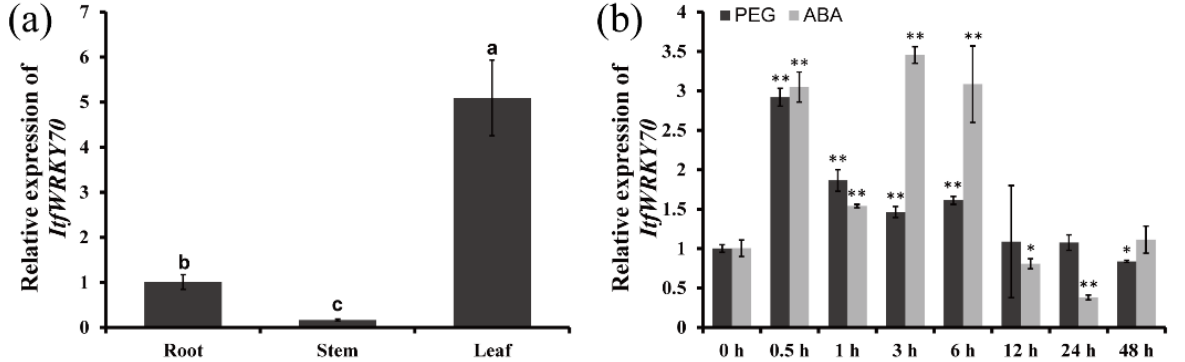
Figure 2. Expression analysis of ItfWRKY70 . ( a ) Expression analysis of ItfWRKY70 in root, stem and leaf tissues of I. trifida . ( b ) Expression analysis of ItfWRKY70 in whole plants of I. trifida after different times (h) in response to 20% PEG6000 and 100 μM ABA, respectively. Data are presented as means ± SE ( n = 3). * and ** indicate a significant difference compared to the wild type (WT) at p < 0.05 and p < 0.01 based on Student’s t -test, respectively.